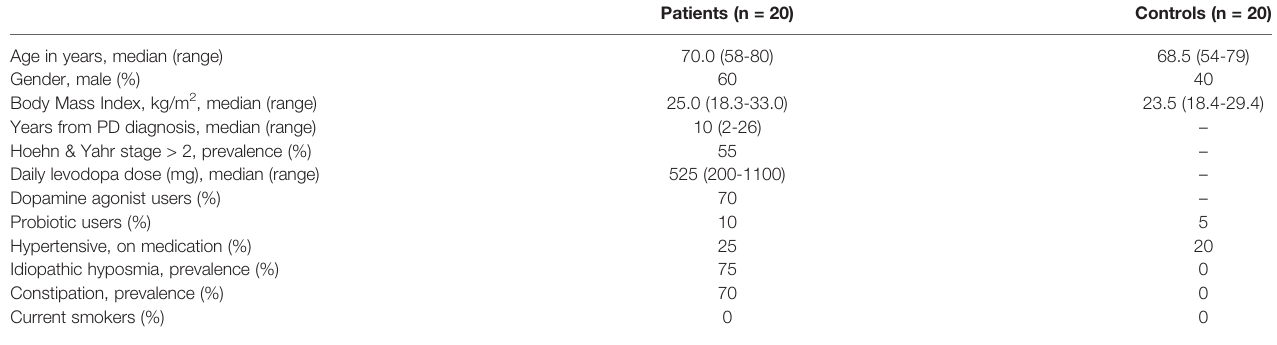
TABLE 2 | Clinical characteristics of patients and